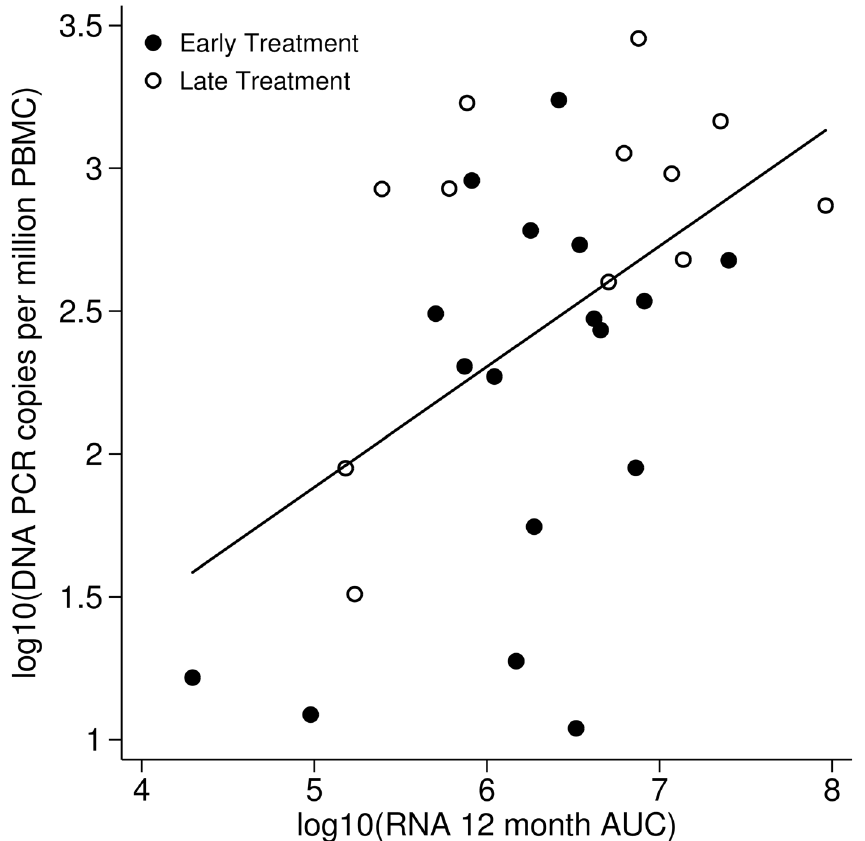
Fig 1. Exposure to HIV-1 replication and PBMC HIV-1 DNA levels one year following cART. The estimated 12 month AUC was significantly positively associated with HIV-1 DNA levels at one year (r = 0.51, p =